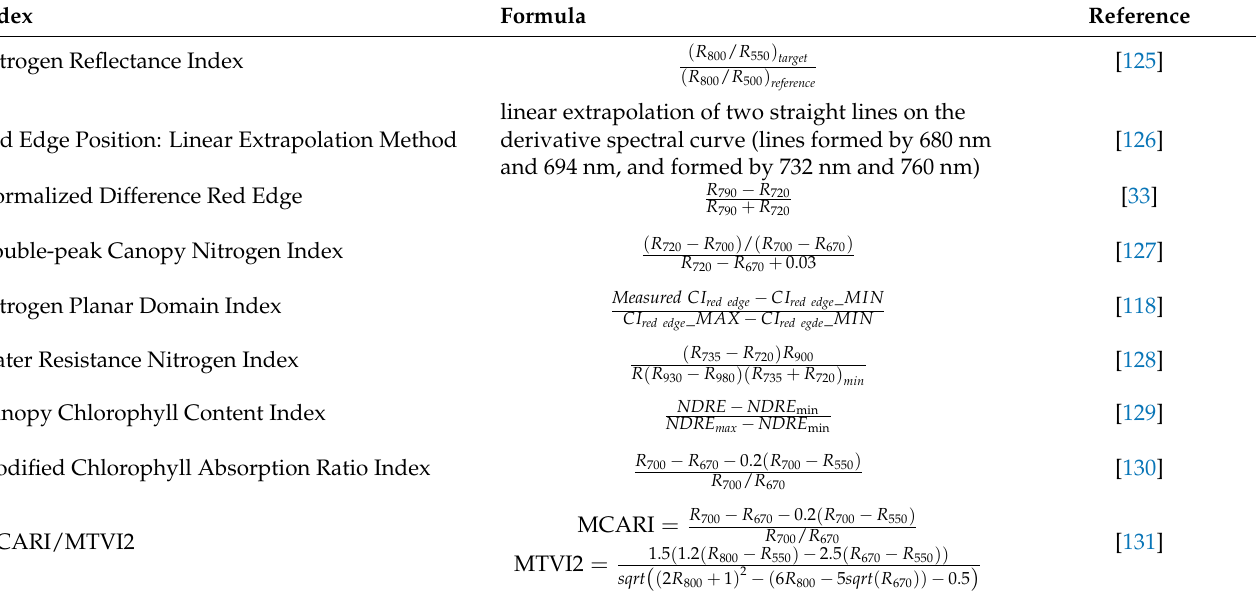
Table 1. Spectral indices for assessing crop N